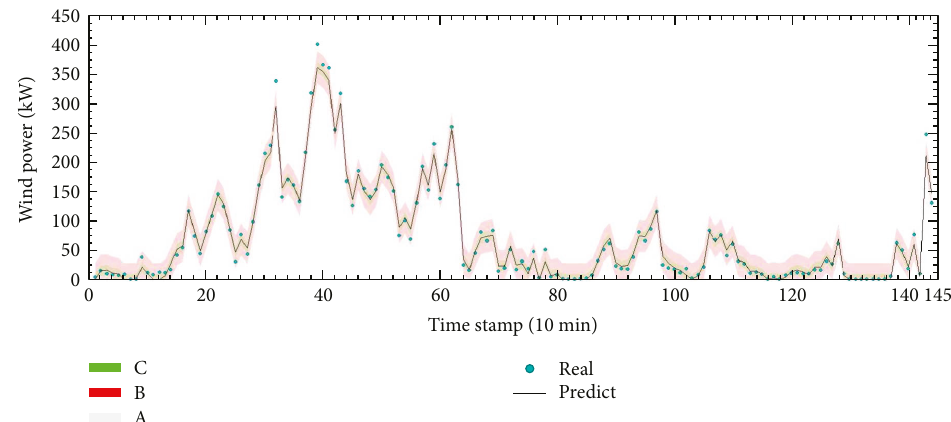
Figure 4: Fuzzy interval prediction for one day ahead (case 1) wind power with coverage grades.